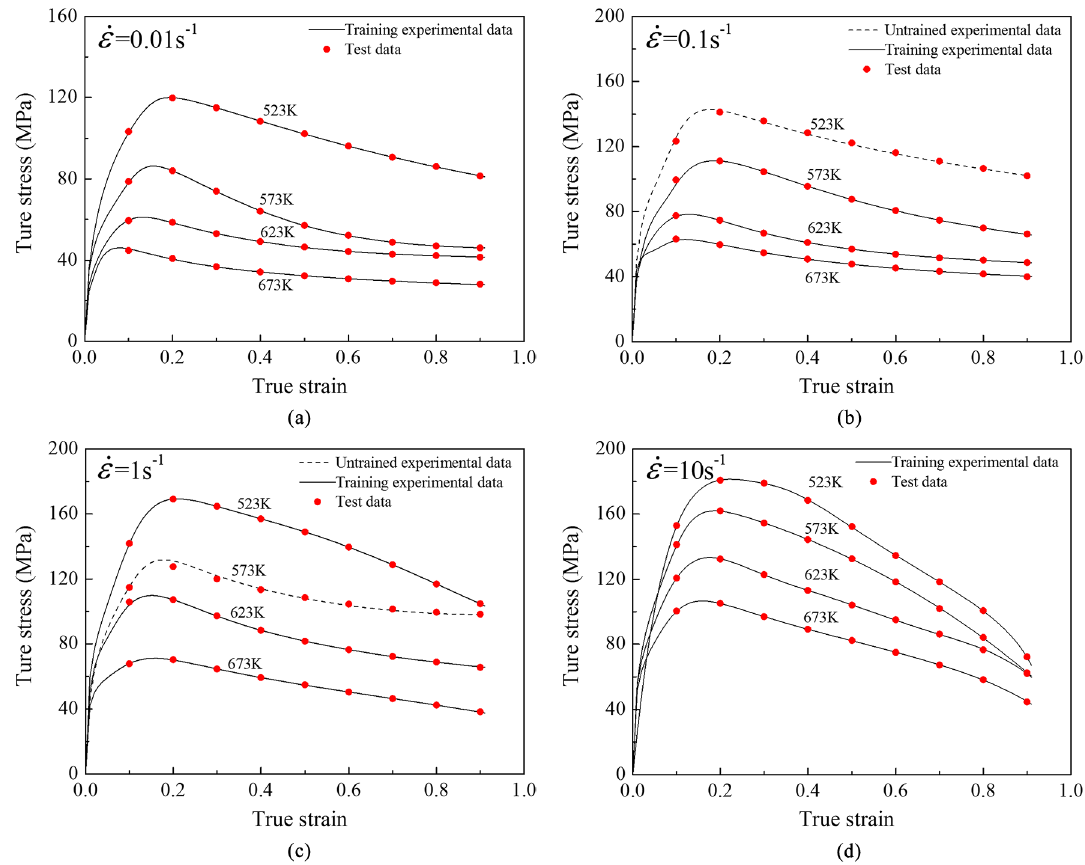
Figure 6. Comparisons between the experimental flow stress and predicted flow stress by BP-ANN model at different strain rates and temperatures (a) 0.01 s –1 , 523-673 K, (b) 0.1 s –1 , 523-673 K, (c) 1 s –1 , 523-673 K and (d) 10 s –1 , 523-673 Table 3. Comparisons between experimental and predicted flow stress data at 523 K & 0.1 s –1 and 573 K & 1 s –1 . Strain rate/s -1